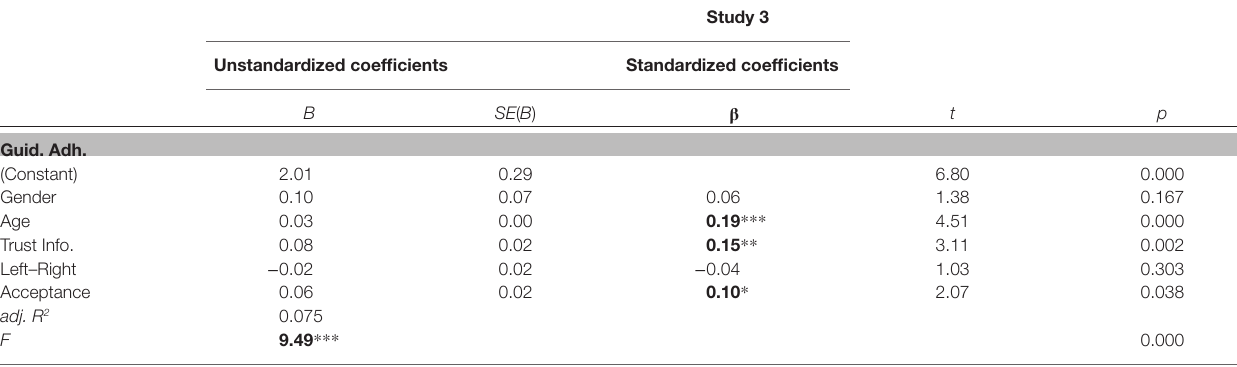
TABLE 11 | Multiple linear regressions on adherence to the social distancing guidelines Study